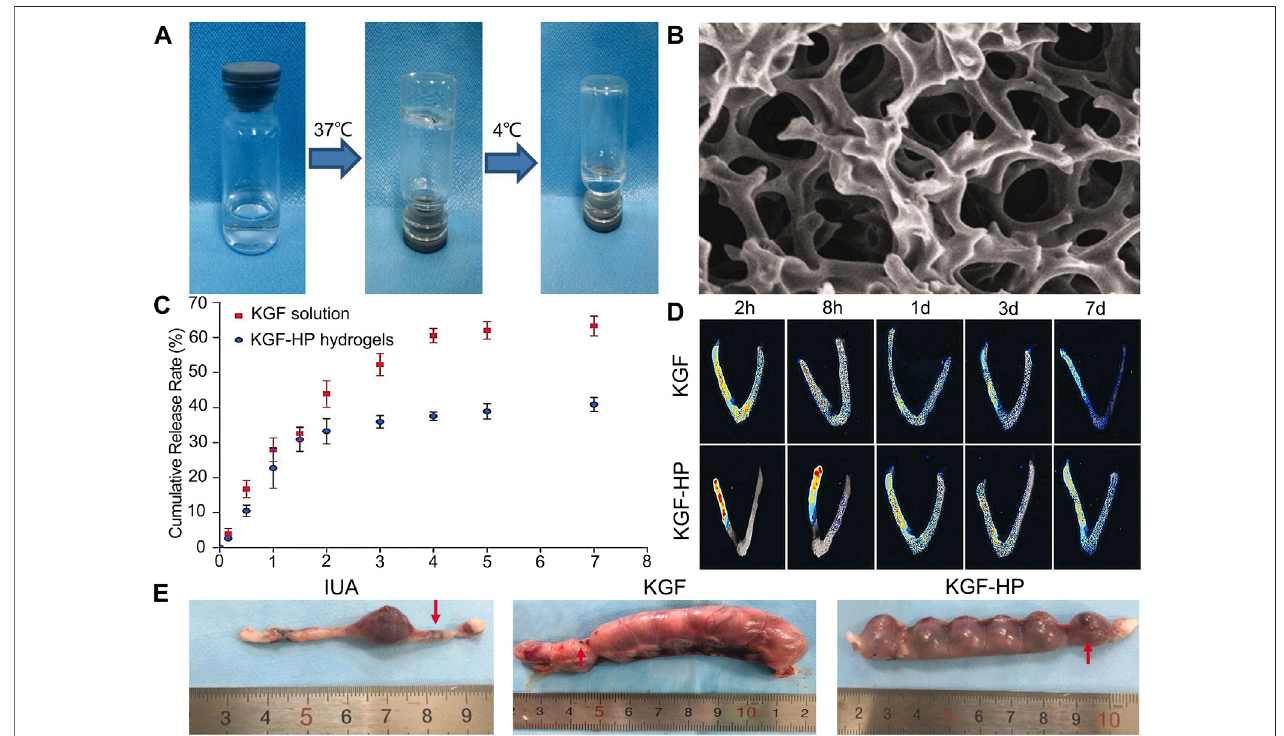
FIGURE 3 | Construction of KGF-loaded HP hydrogel and its curative effect. (A) The temperature-dependent appearance of KGF-loaded HP hydrogel. (B) SEM images of the lyophilized KGF-loaded HP hydrogel. (C) The cumulative release pro fi le of free KGF solution and KGF-HP hydrogel. (D) Representative fl uorescence images of an intact rat uteri after treatment with FITC-labeled KGF or KGF-loaded HP hydrogel. (E) Representative images of embryo implantation for rats treated by different formulations. Reproduced with permission (Xu et al., 2017). Copyright 2017 Taylor & Francis